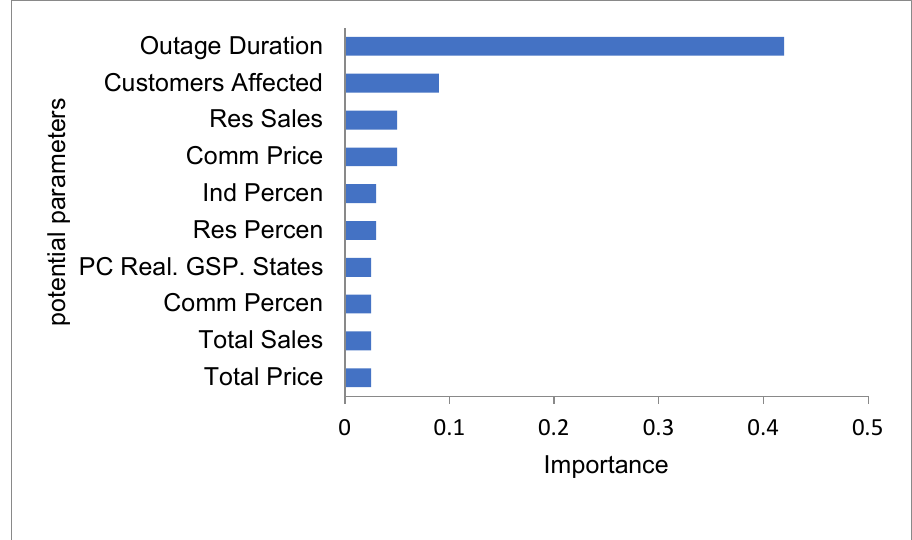
Figure 14. Ranking of top 10 important parameters for revenue loss prediction for the winter storm